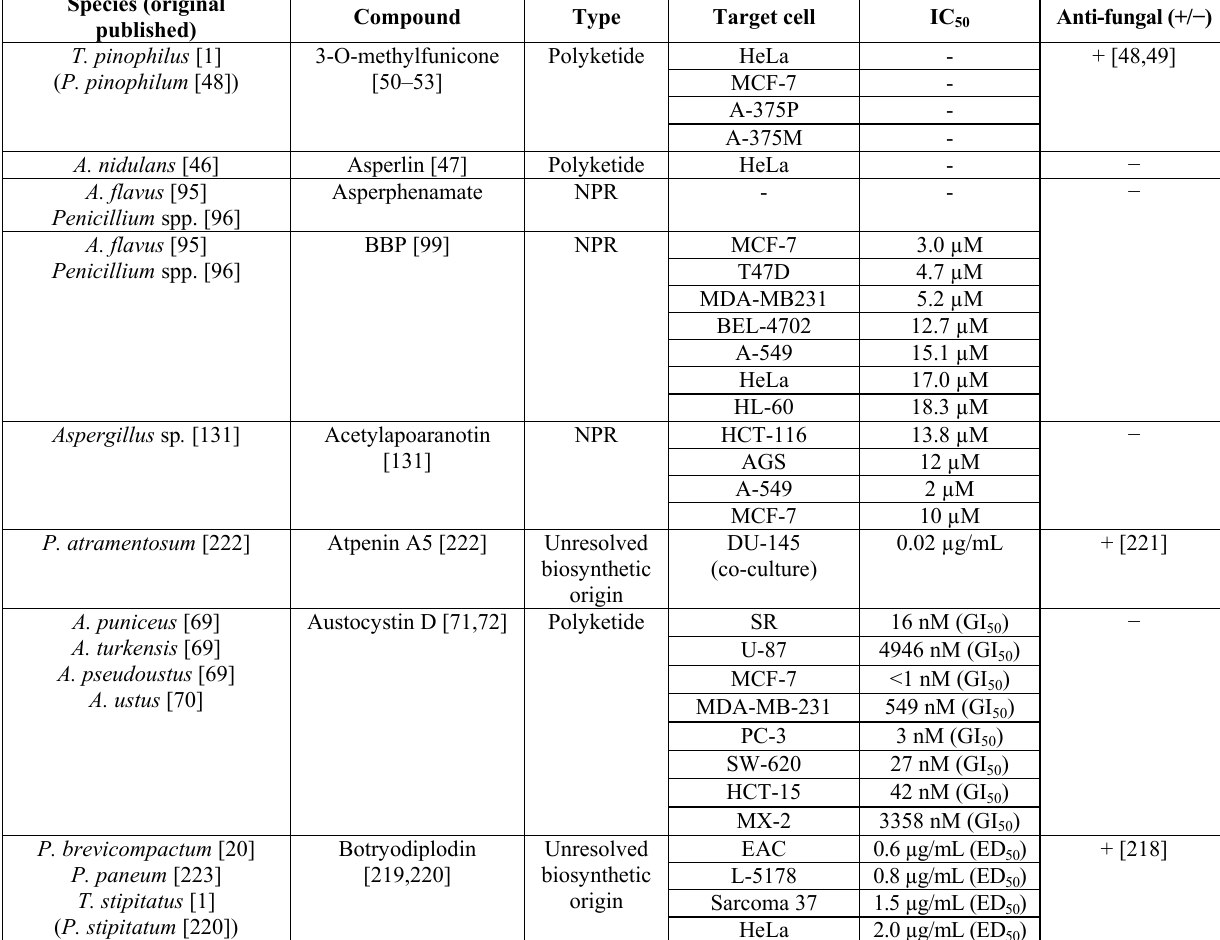
Table 1. List of fungal anticancer natural products primarily produced by Aspergillus , Penicillium and Talaromyces summarizing producing organisms, biosynthetic origin, target (if available), and if the compounds exhibit antifungal cancer cells, IC 50